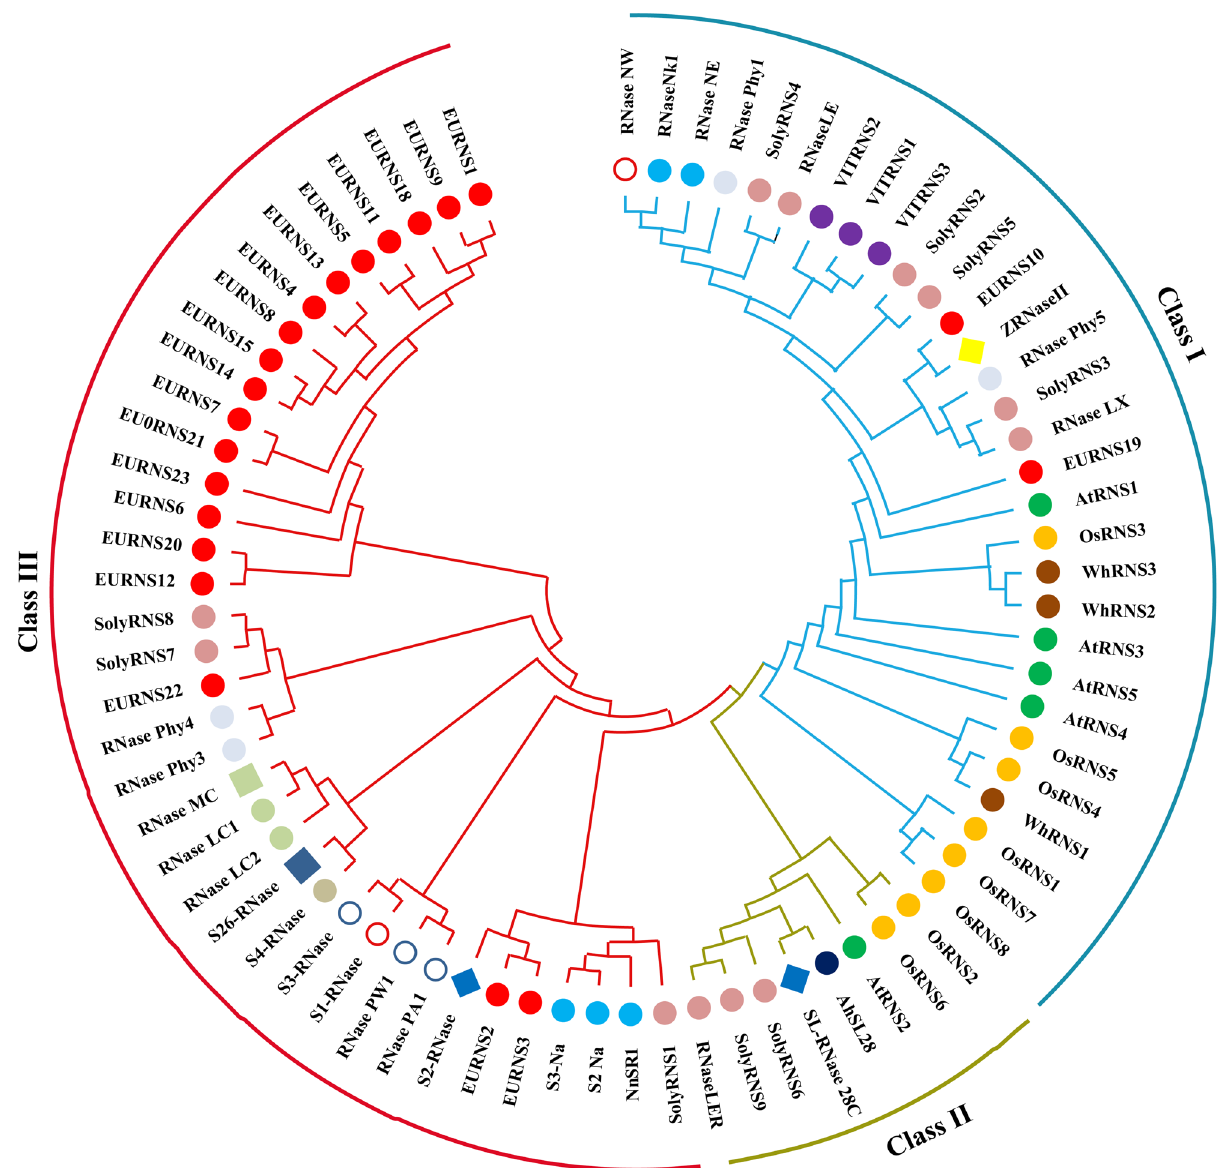
Figure 3. Phylogenetic tree and classification of predcted EURNS proteins. Please refer to Table S5 (2) for the source and accession number of the protein sequence. Maximum Likelihood was created by MEGA X with Muscle multiplied alignment with default